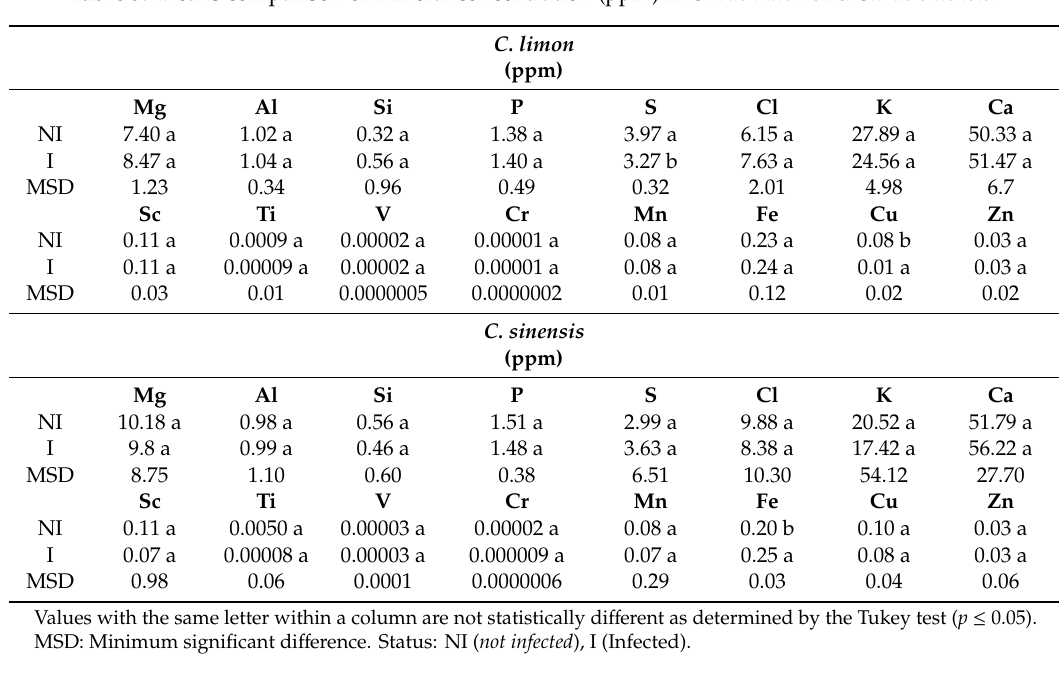
Table 5. Means comparison of mineral concentration (ppm) in Citrus limon and Citrus sinensis .